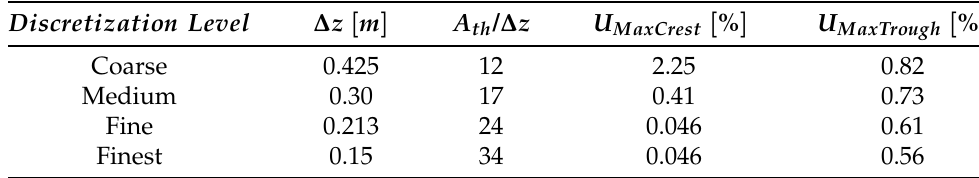
Table 4. Spatial convergence study for the steepest wave (sea state 5a). The spatial discretizetion is evaluated through the numerical uncertainty U [ % ] , for the maximum wave crest U MaxCrest and the deepest wave trough, U MaxTrough